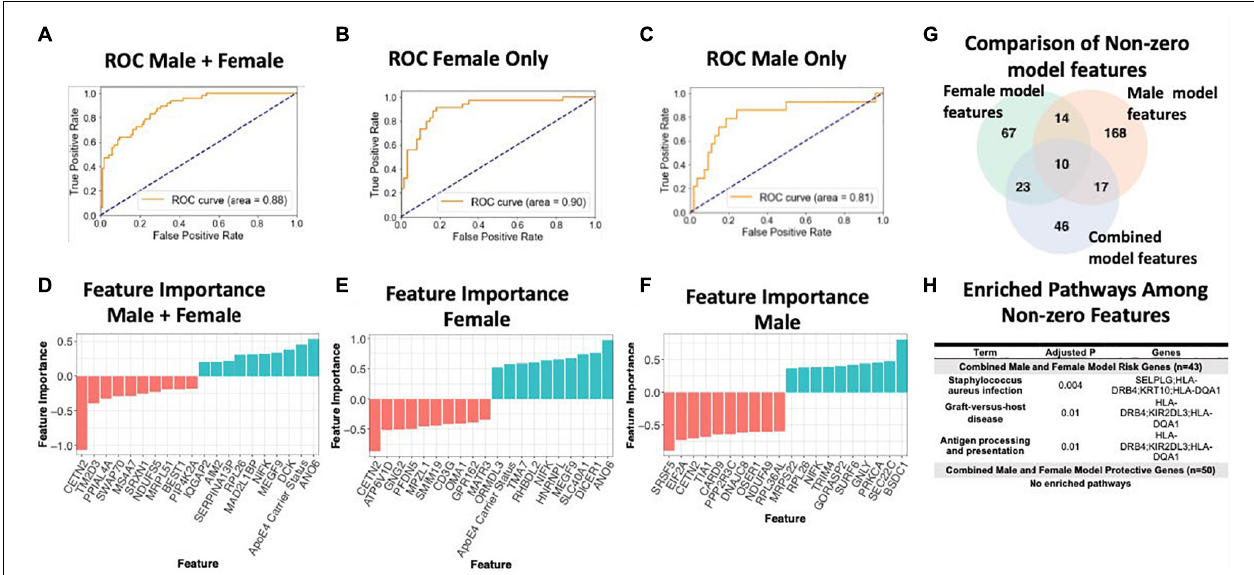
FIGURE 6 | Linear SVM clinical + molecular model in whole blood. (A–C) Receiver operating characteristic (ROC) curves depicting performance of each linear SVM model on a test set composed of 25% of samples. Features include gene expression data obtained via meta-analysis, age, sex, education, and APOE ε 4 status. Three models were fit for male and female pooled samples (A) , female samples only (B) , and male samples only (C) . (D–F) Feature importance plots for features with non-zero importance in the combined male and female model (D) , female model (E) , and male model (F) . A positive feature importance means that the expression of that feature increases the likelihood of being classified as AD (risk factor). A negative feature importance means that expression of the feature expression reduces the likelihood of being classified as AD (protective factor). (G) Comparison of non-zero features between combined male and female model, female model and male model. (H) Enriched pathways among non-zero features. An adjusted P -value cutoff of 0.05 was used for significance to increase